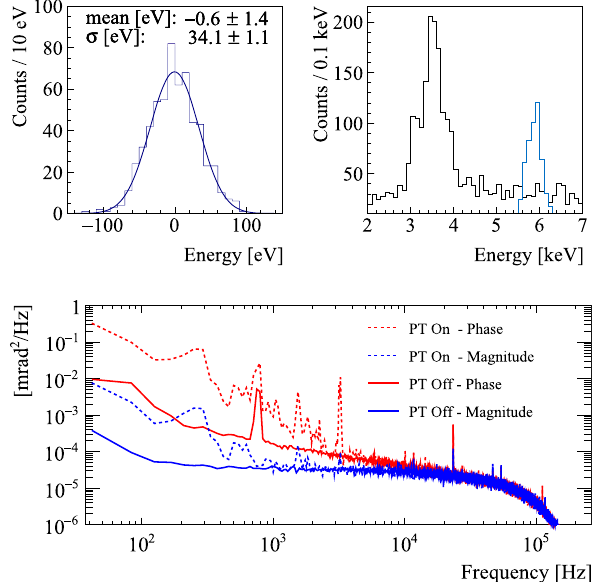
Fig. 6 Left: Light-calibrated energy distribution of noise triggers with the pulse-tube cryocooler off. Bottom: Comparison of the noise power spectra of the magnitude and phase readout with the pulse-tube cry- ocooler on and off. Right: light-calibrated energy spectrum acquired with the 55 Fe source (black) and of optical pulses close to the nominal energy of the source (cyan). The peak of 55 Fe is shifted to lower ener- gies because of the position of the source, which fires at a corner of the substrate opposite to the KID position, while the light illuminate the substrate